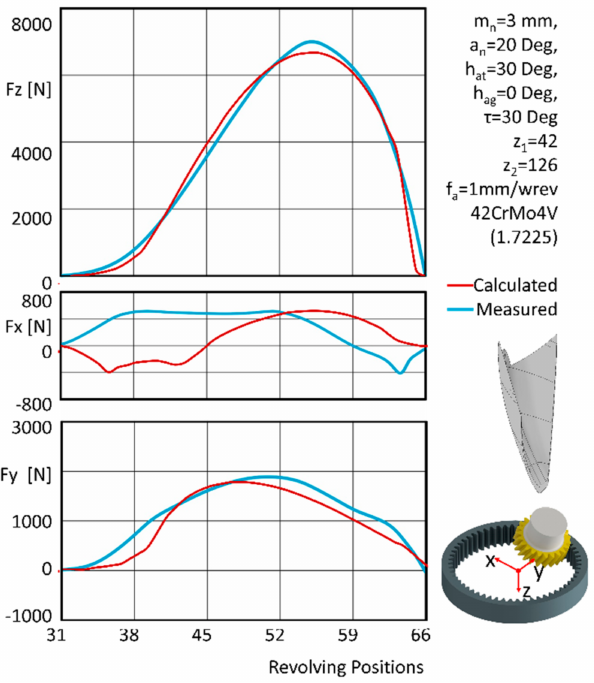
Figure 5. Cutting force validation.